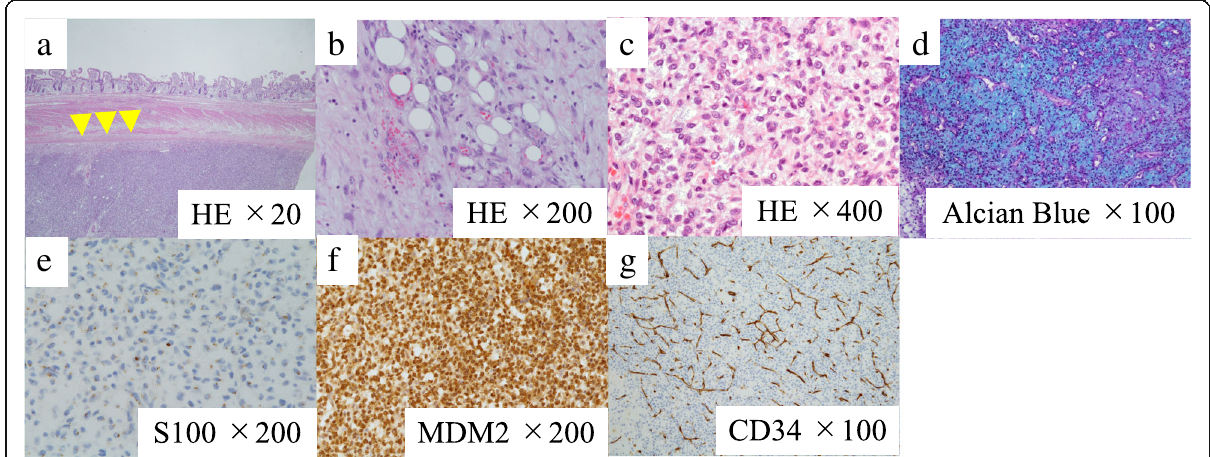
Fig. 6 Histopathological examination of the intra-abdominal tumor. a – c Hematoxylin and eosin-stained sample showed various sizes of spindle- shaped or round-shaped cells in the myxoid parenchyma, surrounded by fibrous capsule, with hyperplasia of the capillary or microvascular vessel, collagen fibers, and adipocyte cells. a The small intestine serosa shown above the tumor surface was intact (arrowhead), and no tumor invasion to the small intestine was observed. d . Alcian blue staining for the mucinous component was positive. e – g Immunostaining with S100 and MDM2 was positive and negative with